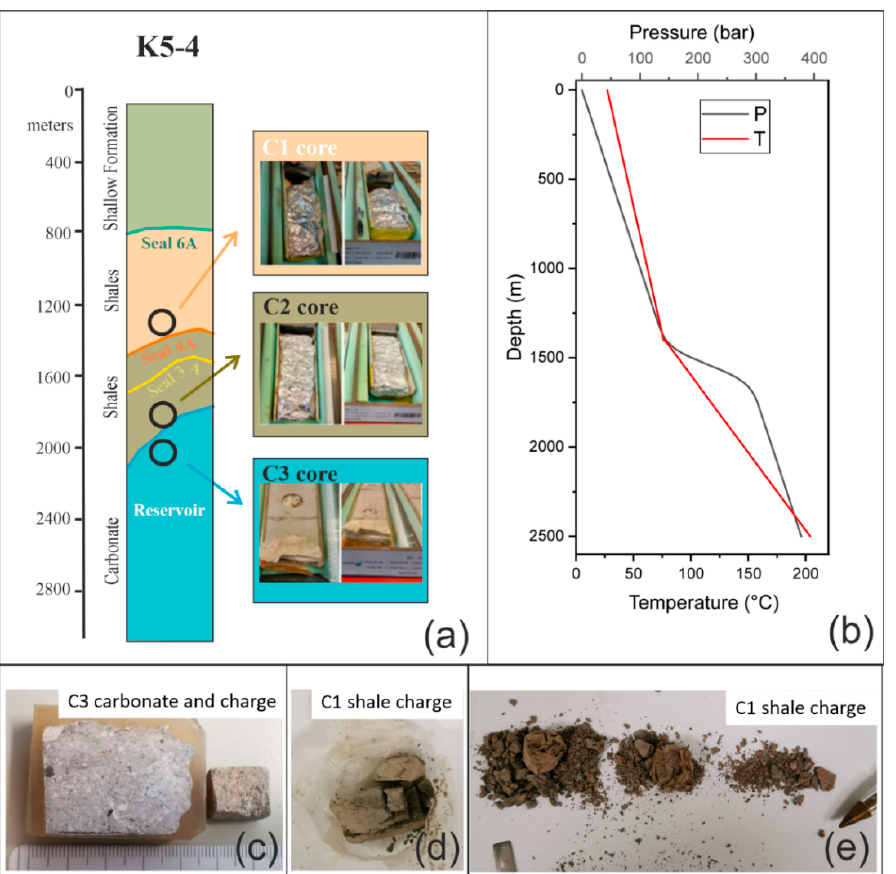
Figure 1. ( a ) Simplified stratigraphic log of the selected structure with cores location and housing. Depths (m) are referred to sea level. ( b ) Geothermal and geobaric gradient as measured in drilled wells; ( c ) carbonate C3 sample as its original form (larger block) and related charge after experiment (smaller cube); ( d ) shale C1 sample after 2 days of experiment; ( e ) shale C1 sample after 5 days of experiment.